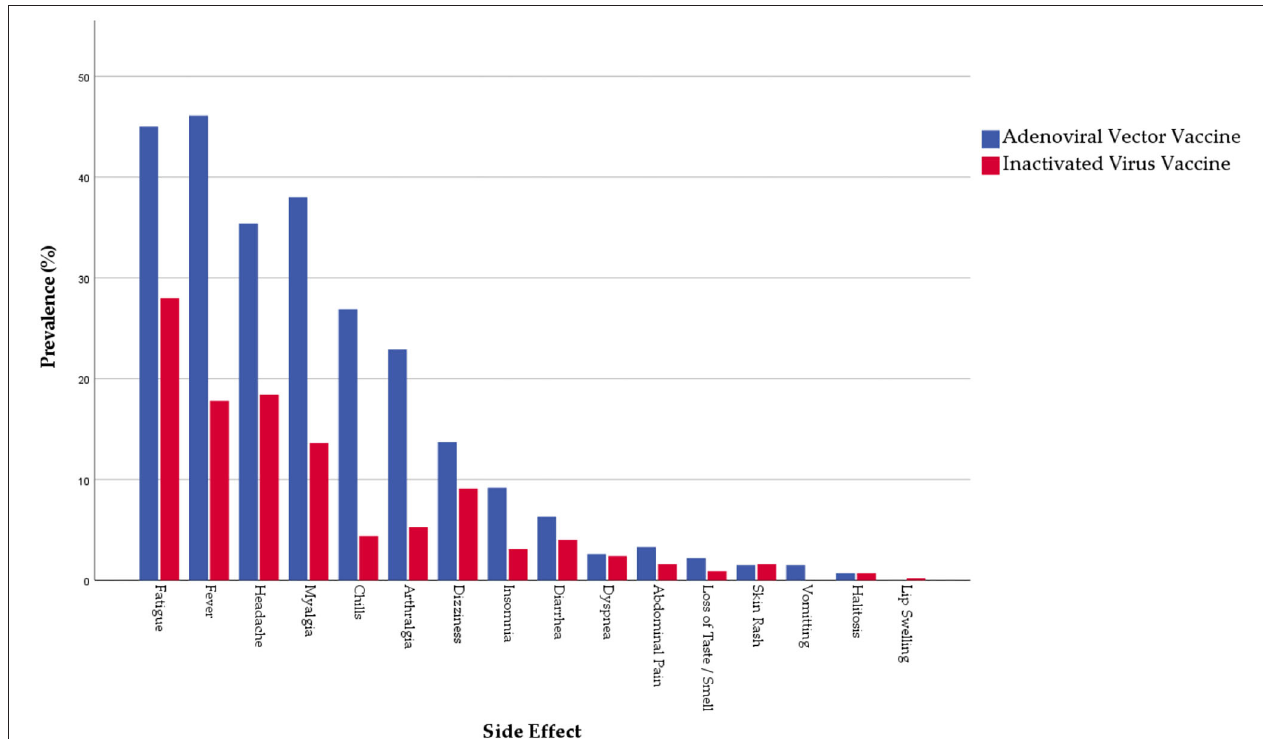
FIGURE 2 | Prevalence of systemic side effects reported by Algerian healthcare workers ( n =